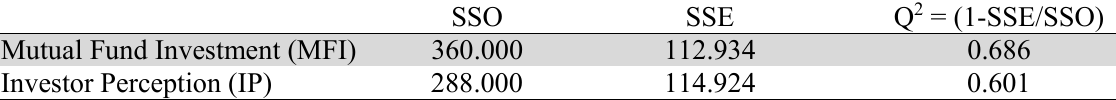
Predictive relevance (Q 2